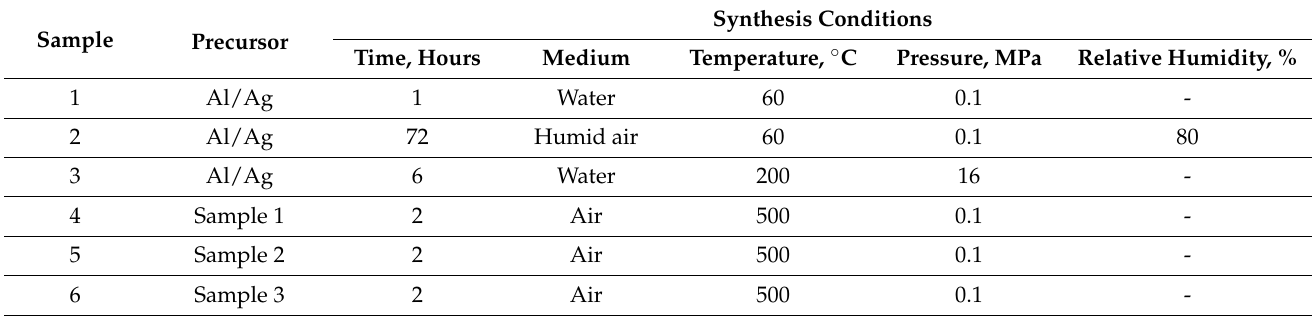
Table 1. Conditions for obtaining